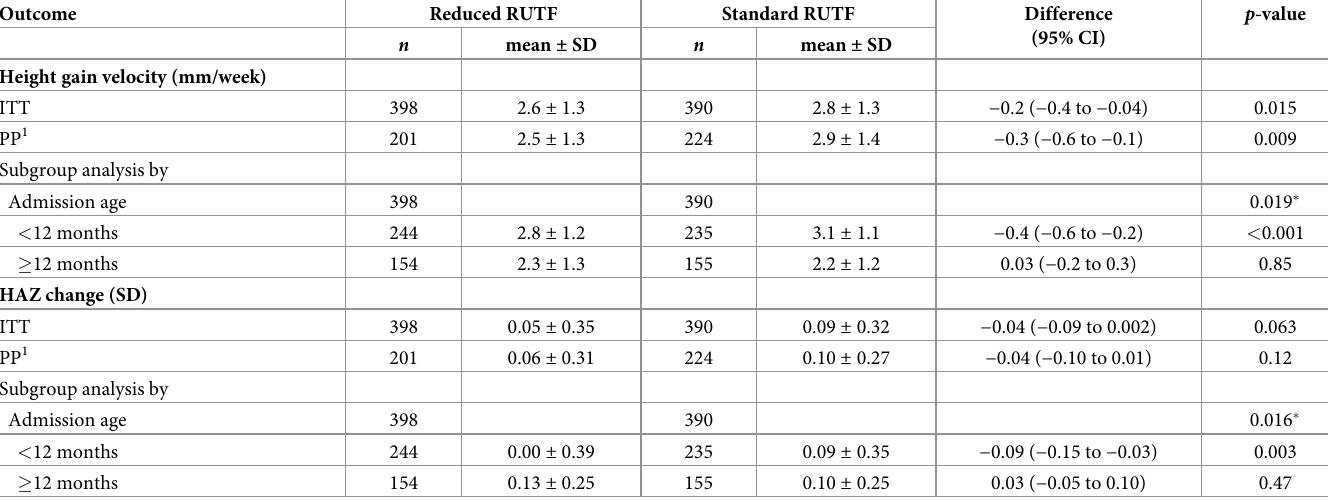
Table 6. Height gain velocity (mm/week) and HAZ change (SD) from admission to discharge of children with SAM randomised to reduced or standard RUTF dose and difference (95% CI) in unadjusted model.